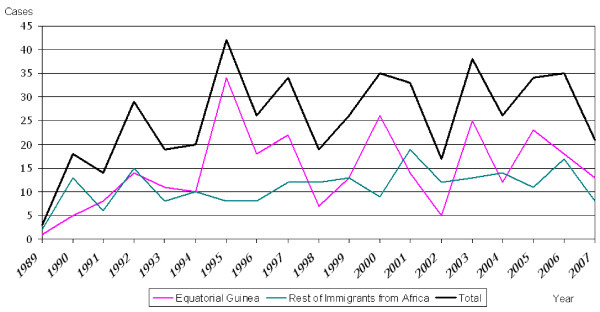
Evolution of the recorded malaria cases. Patients from Equatorial Guinea compared to other Africans. Barcelona, 1989–2007.